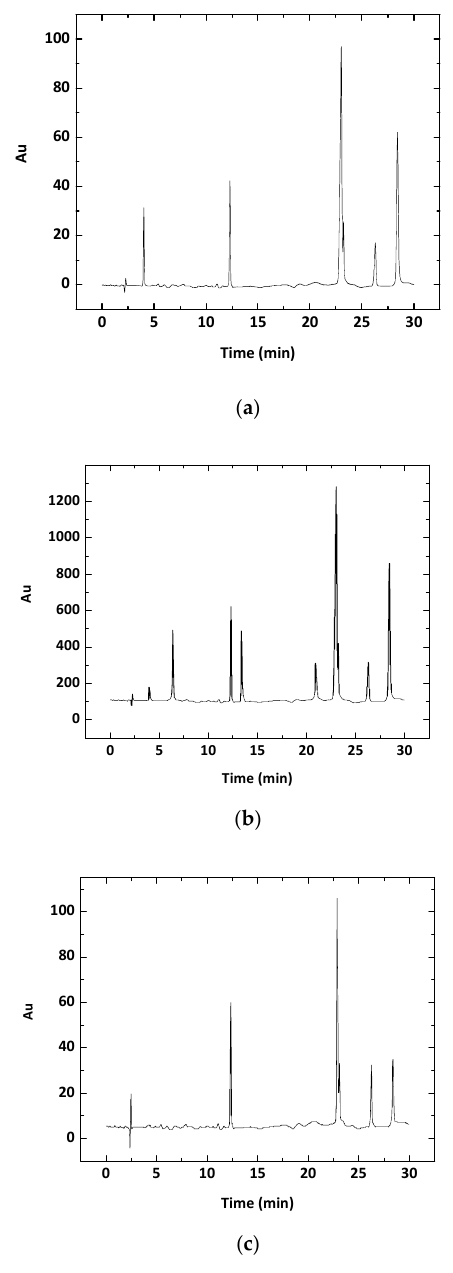
Figure 3. Chromatograms of the analytical standards of ( a ) photosynthetic pigments, ( b ) Microcystis aeruginosa LTPNA 01 ( b ), and ( c ) a bloom sample collected in the field. Retention time (minutes): 4.05 (unidentified pigment); 12.29 (mixoxanthin); 23.02 (chlorophyll-a); 26.32 (echinenone), and 28.44 ( β -carotene).